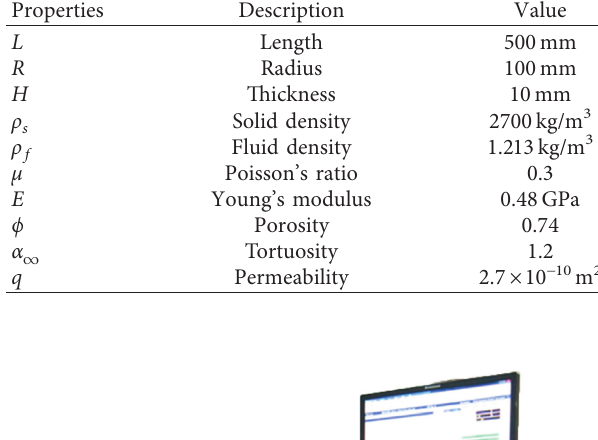
Table 1: Parameters of the porous cylinder shell. Properties